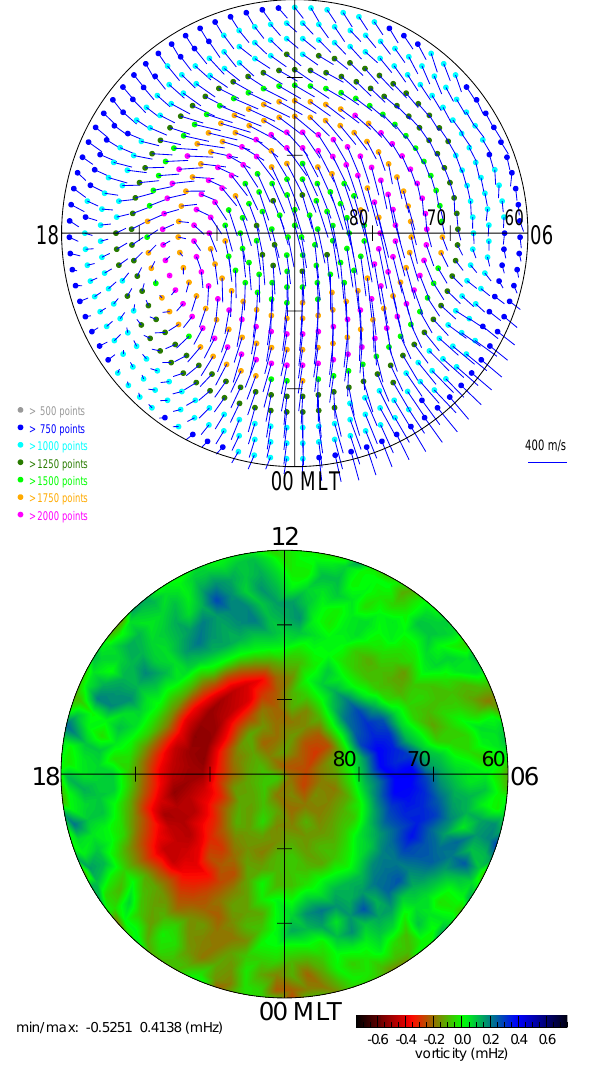
Fig. 1. Average statistic thermospheric wind pattern at ∼ 400km height over the South polar hemisphere obtained from CHAMP ac- celerometer data of the whole years 2002 and 2003. The MLT ver- sus magnetic latitude dials have an outer boundary of 60 ◦ . The neutral wind direction and magnitude are shown in the upper panel by small vectors with the origin in the dots at the bin’s position. The bottom panel shows the vorticity pattern of the horizontal wind vec- tors. Negative values (red) indicate a clockwise, positive (blue) a counterclockwise circulation according to the colour bar at the bot- tom. Minimum and maximum values are indicated there as well.